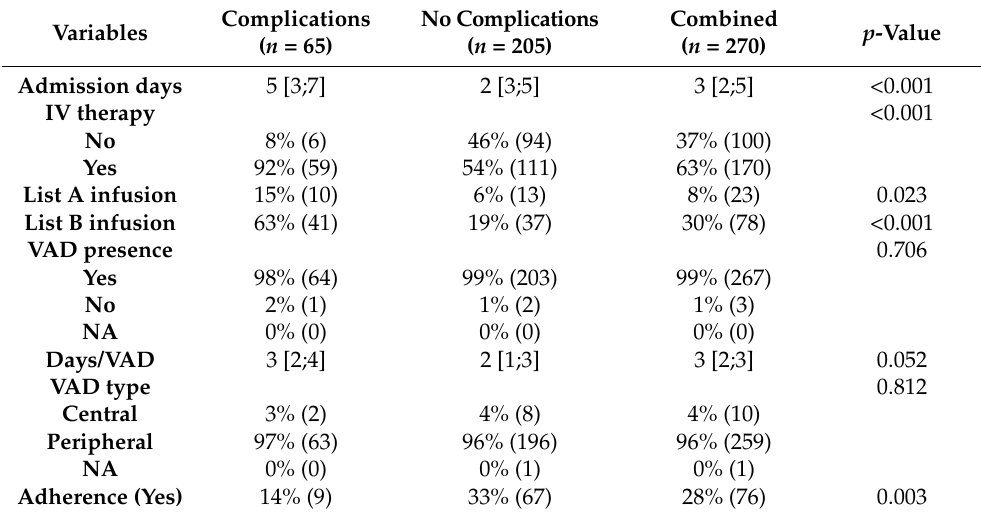
Table 3. Characteristics of the overall events (i.e., number of VADs) according to the presence of complications that occurred during hospitalization. Data are presented as the median (I, III quartile) for continuous variables and as percentages (absolute numbers) for categorical